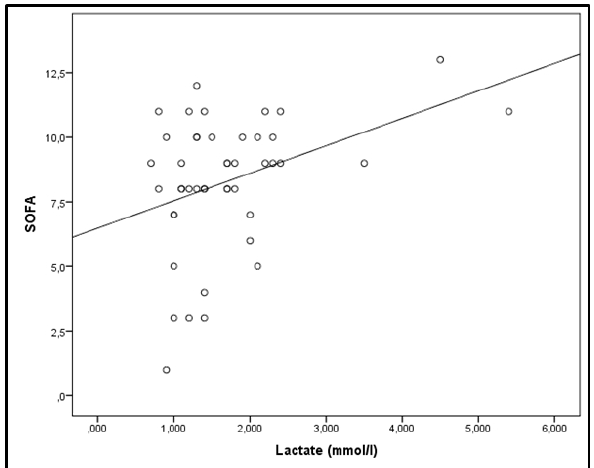
Figure 5. Correlation of lactate levels and SOFA scores on ICU admission. Correlations were performed by Spearman’s correlation coefficient. r 2 = 0.33, p = 0.003.